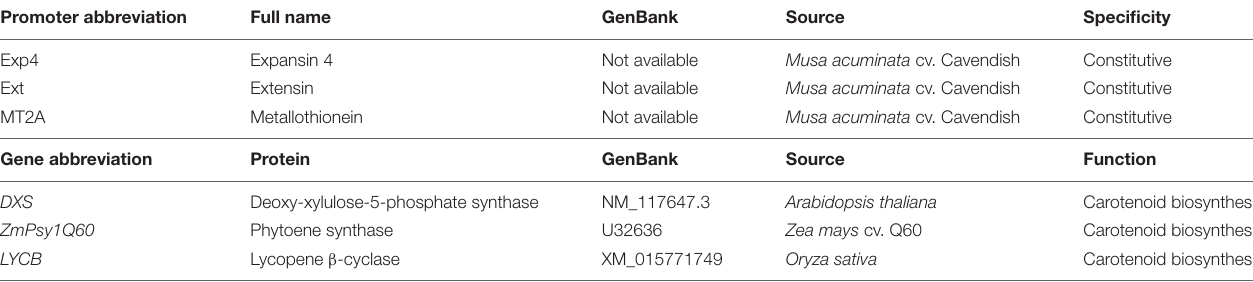
TABLE 2 | List of new promoters and genes tested in AFT-2 of the Banana21